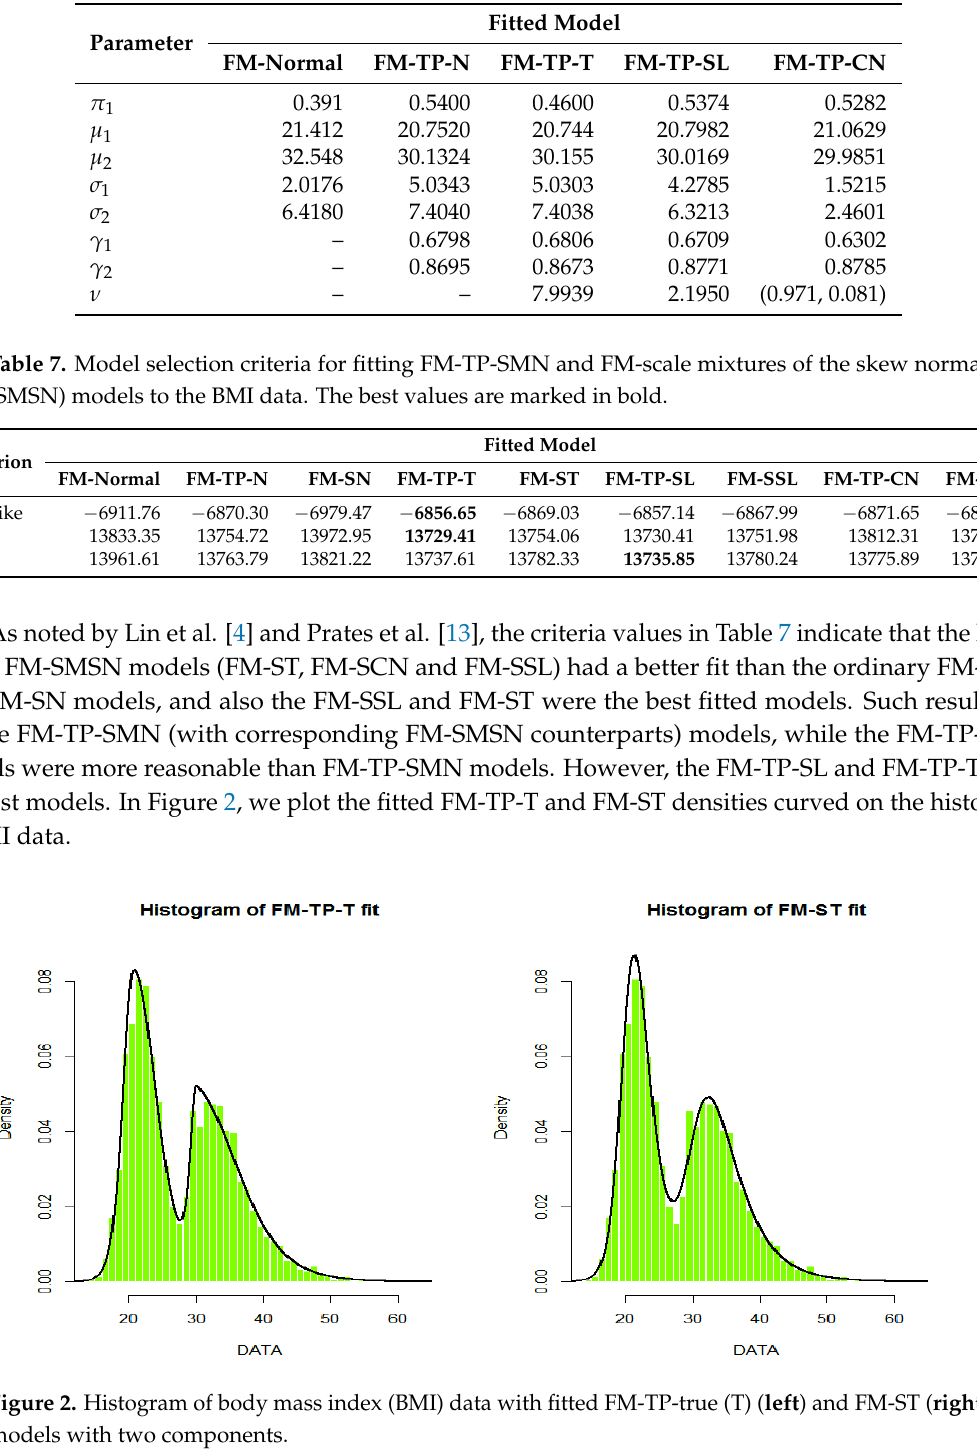
Table 6. ML estimation results for fitting FM-TP-SMN models to the body mass index (BMI) data.